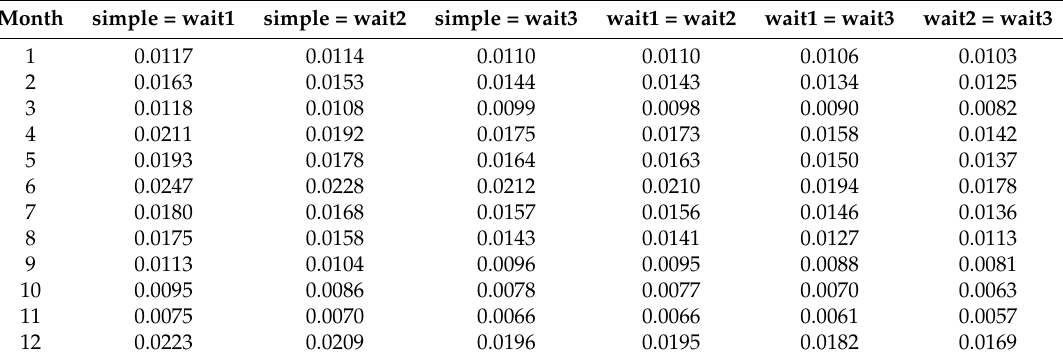
Figure 9. Results for the total costs for the major repair of a turbine blade. We assume an electricity price of 30.84 Euro-cent (Germany second half 2017 from [16]. The original strategy is the cheapest option independent of the season. Table 6. Electricity price at which a break-even is reached between two policies in € . A value is calculated for each month of the year, for the major gearbox replacement, with a repair time of 231 h. This comparison is not complete and solely meant as an example to show that novel policies indeed become cheaper than the original policy for low enough electricity